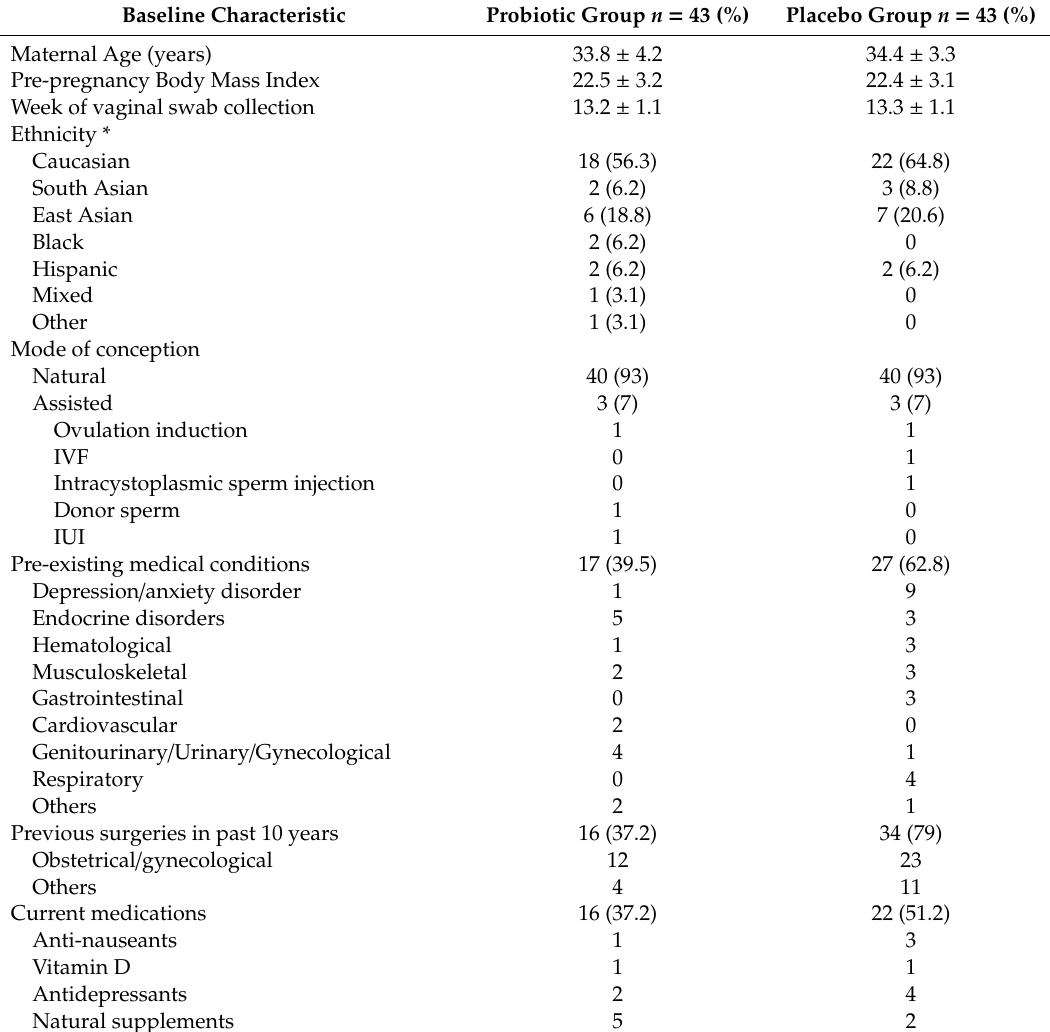
Table 1. Characteristics of pregnant women randomized at 13 weeks of gestation. Comparison between the probiotic group and the placebo group was performed with Student’s t-test or Chi-square ( p >